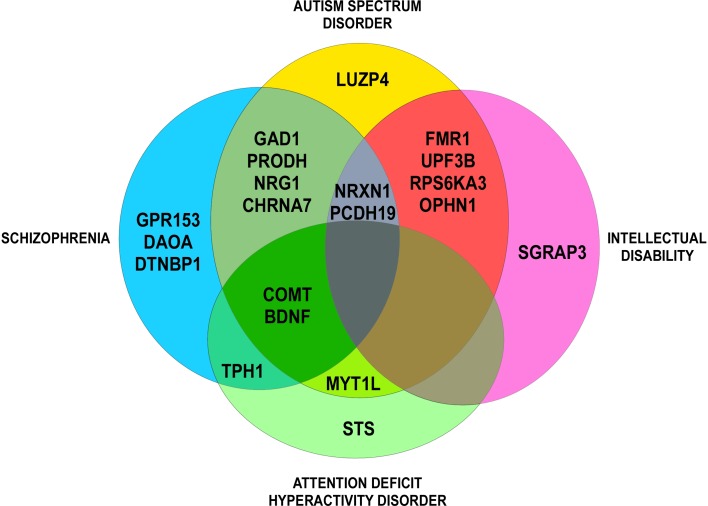
Venn diagram: evidence for genetic overlap in neurodevelopmental disorders (Phenocarta Database).